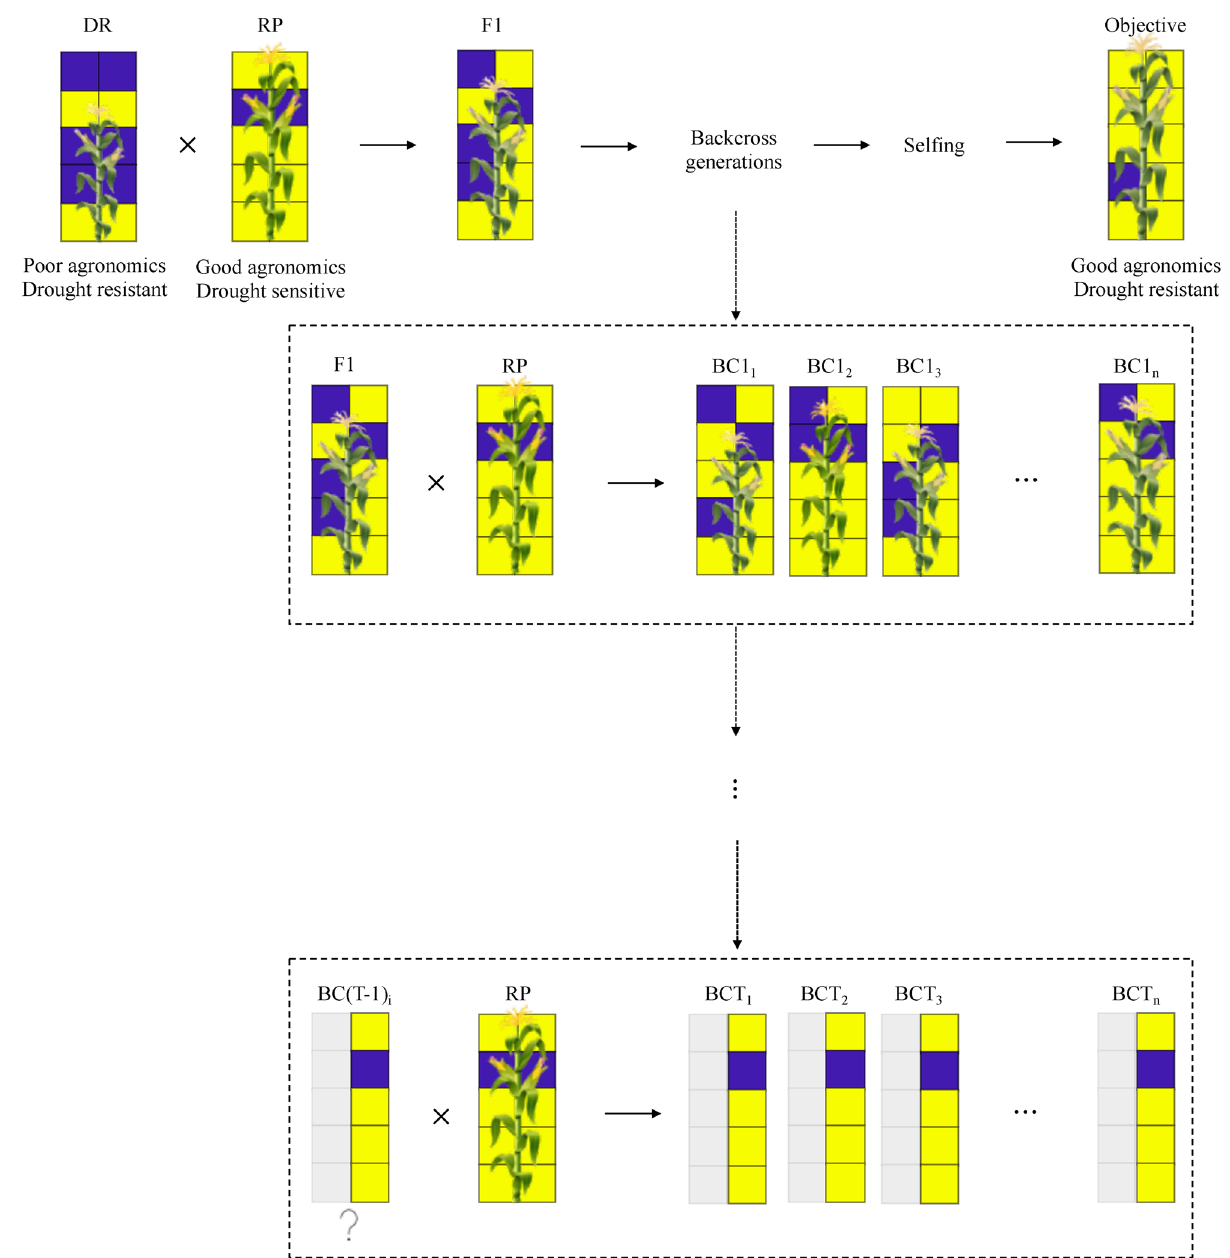
Figure 1. A schematic overview of the backcross